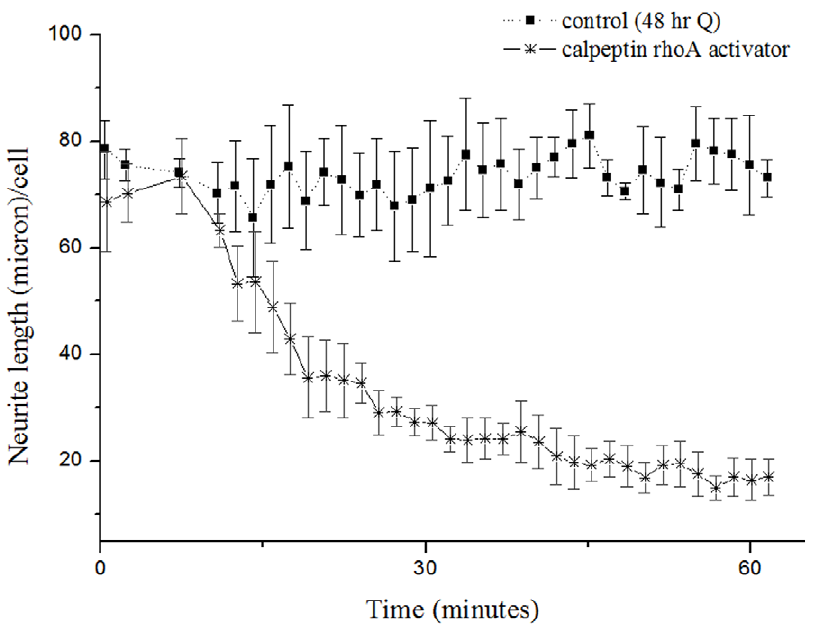
Figure 5. Calpeptin causes a rapid retraction of isoquercitrin induced neurites. After 48 hour incubation with isoquercitrin, neurite retraction was quantified upon addition of RhoA activator calpeptin over a period of 60 minutes (n=3, one way ANOVA for repeated measures, F 1,4 =27.310, P=0.006). Acquisition was started 5 9 after the addition of the molecule. The maximum time of one cycle of acquisition was about 1 9 . Post hoc Bonferroni test revealed significant differences between the control and the treatment with calpeptin, for alpha=0.05. Data are shown as means 6 s.e.m.